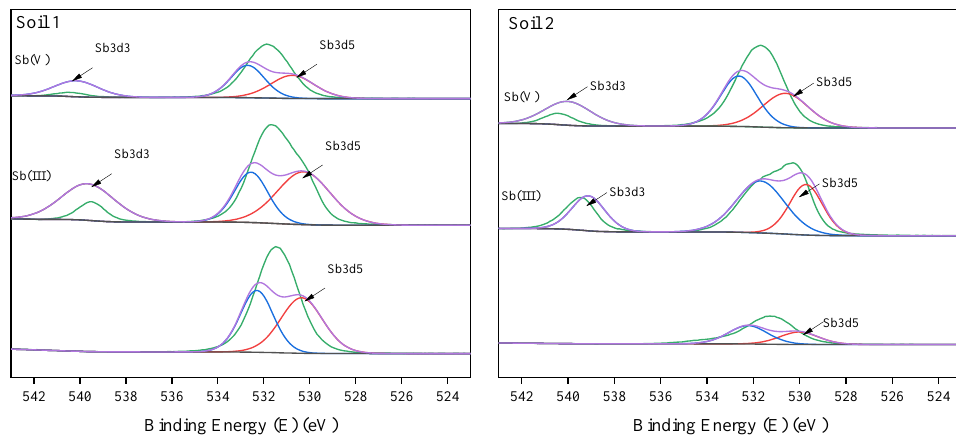
Figure 9. XPS spectra of the soil samples before and after adsorption.